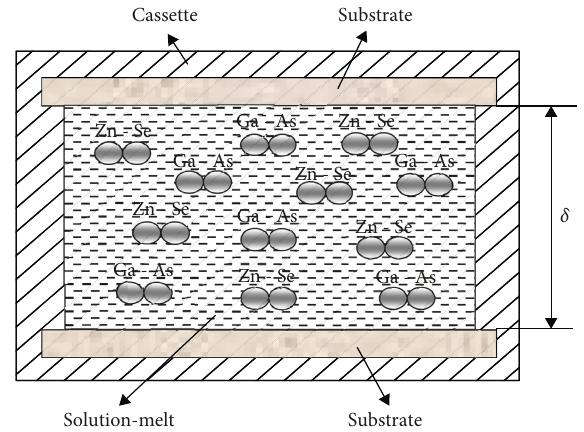
Figure 2: Diagram of a graphite cassette with horizontally placed substrates and a solution-melt (the thickness of the gap between the substrates is δ �